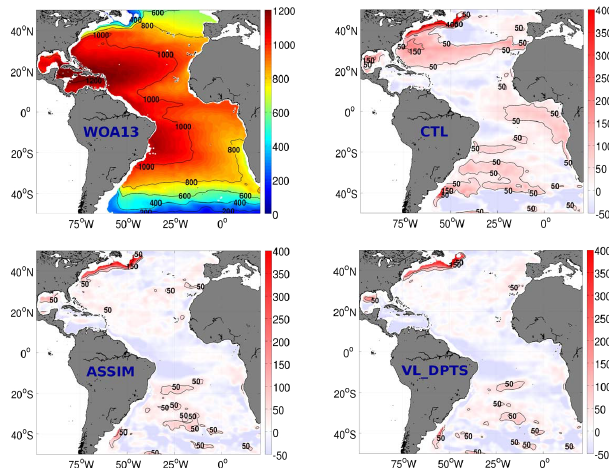
Figure 8. Heat content (MJm − 2 ) to 300m of the WOA13 clima- tology and the model mean minus WOA13 for the CTL run and the prior state of the ASSIM and VL_DPTS runs over the period from 1 January 2010 to 31 December 2012. Regions shallower than 300m were not considered.